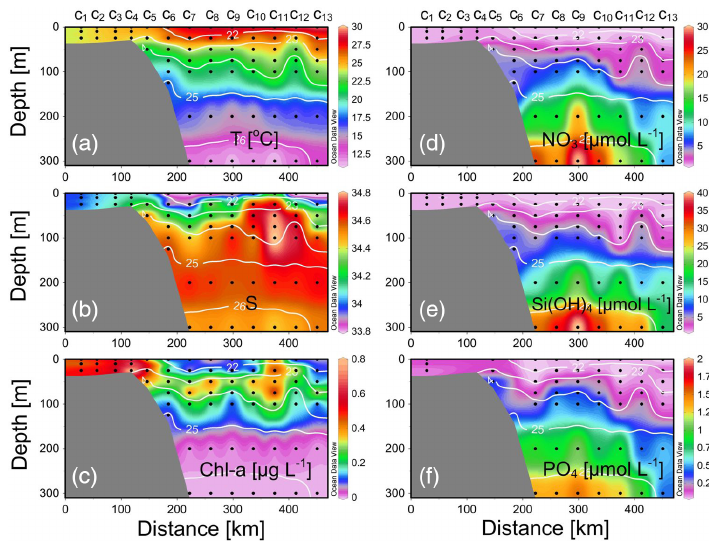
Figure 3. Vertical distributions of (a) temperature ( T ), (b) salinity ( S ), (c) chlorophyll a (Chl a ), (d) nitrate (NO 3 ), (e) silicate (Si(OH) 4 ), and (f) phosphate (PO 4 ) along the coastal transect of the northern South China Sea. Overlaid white lines in each panel are